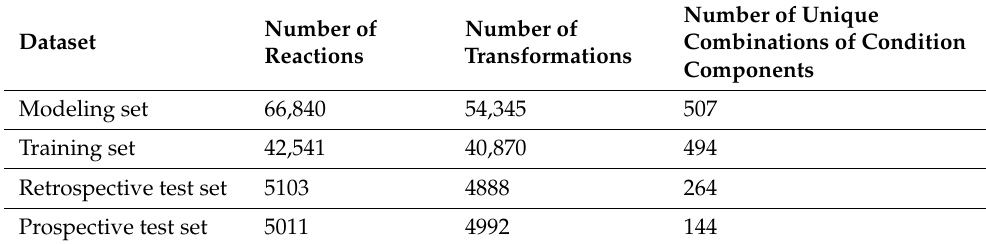
Table 3. Dataset